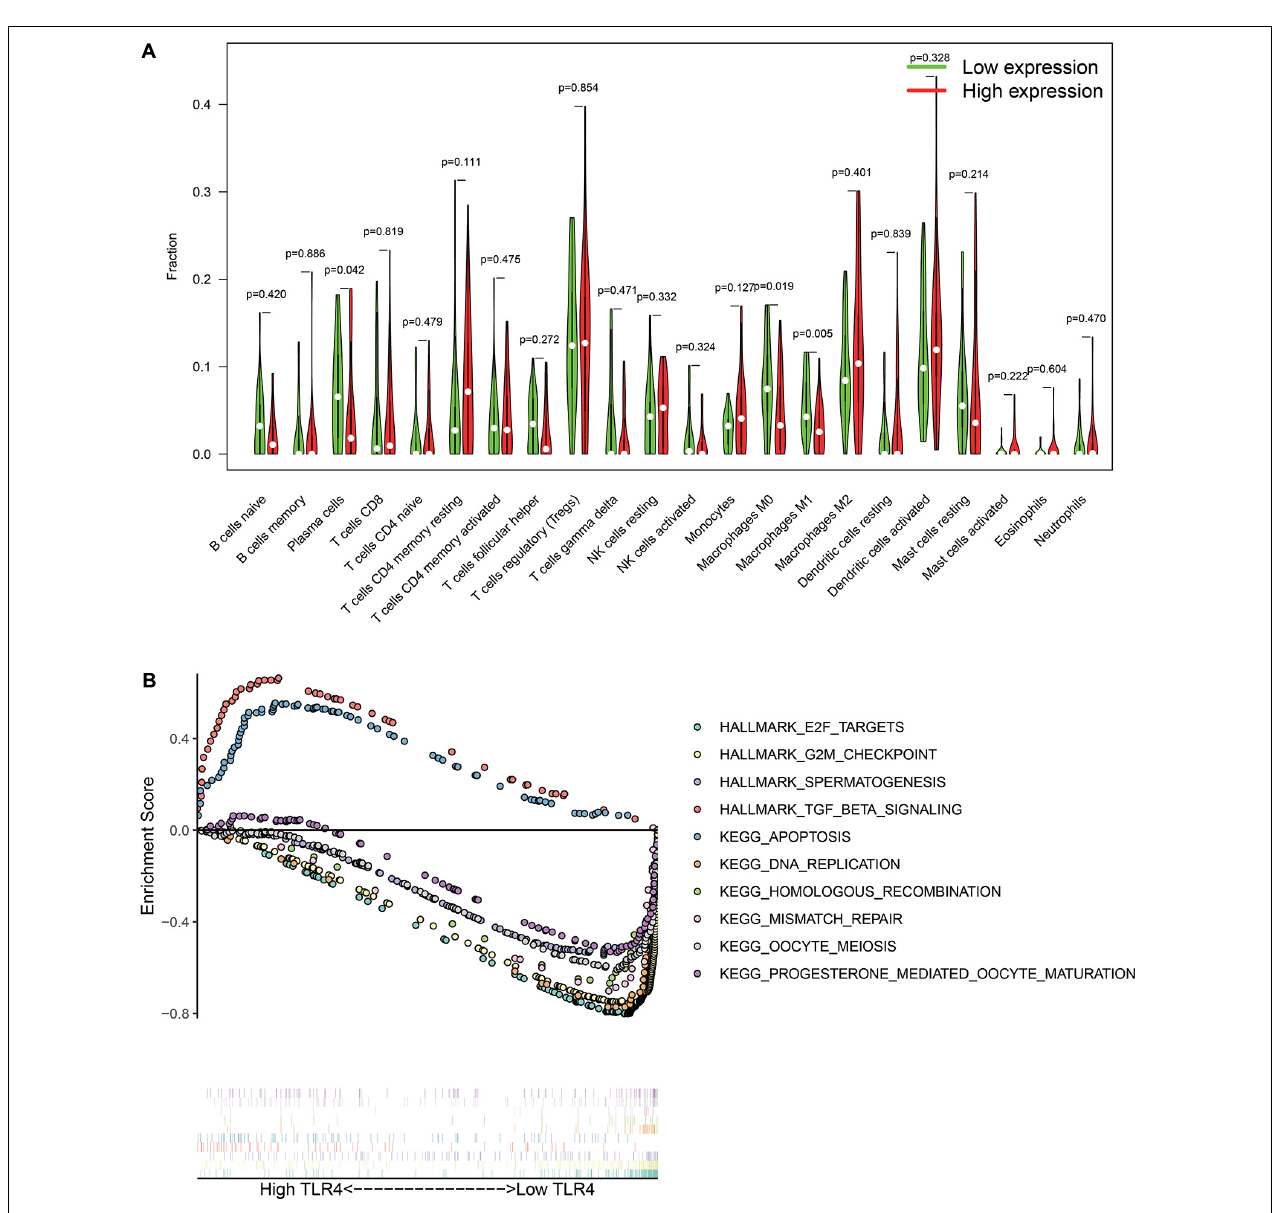
FIGURE 5 | Differentially immune cell infiltration (A) and alterative pathways (B) between high TLR4 expression groups and low TLR4 expression